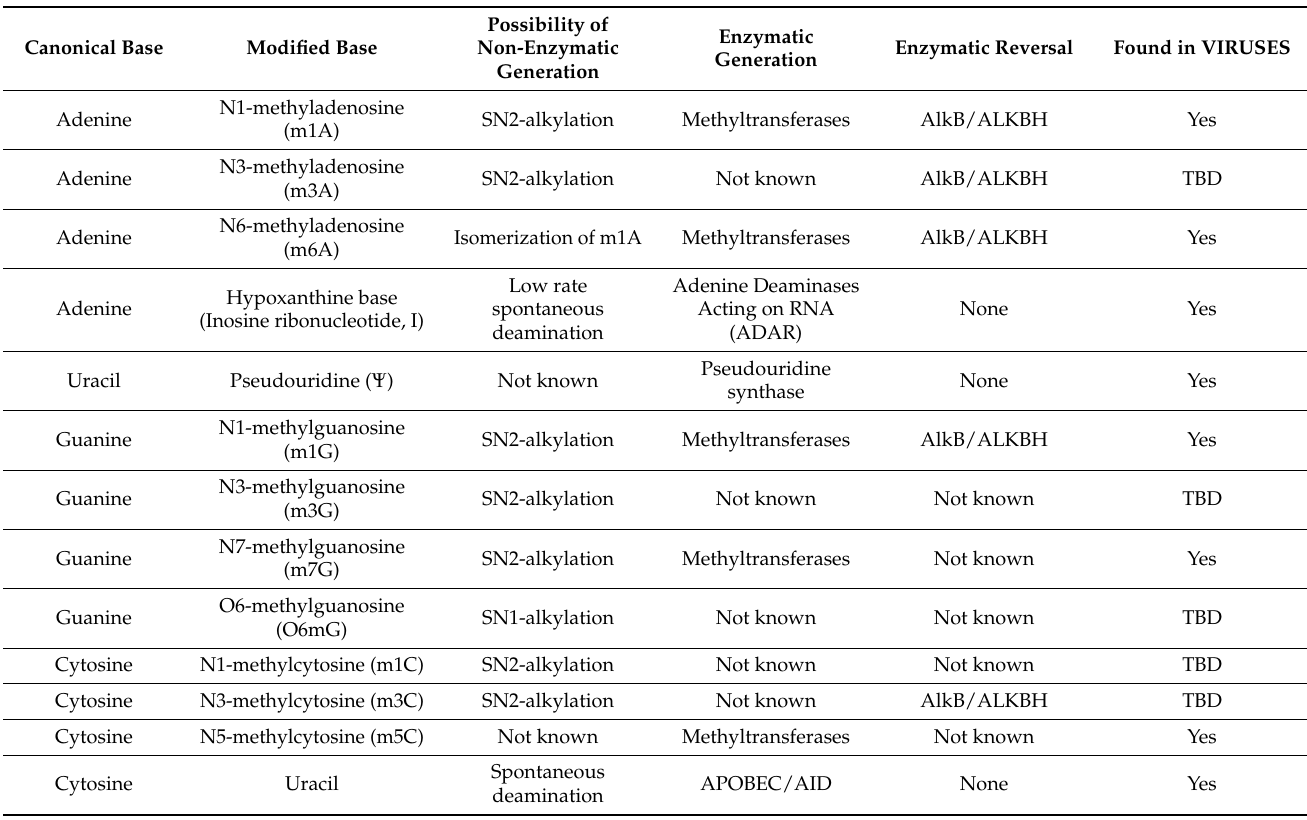
Table 1. RNA base